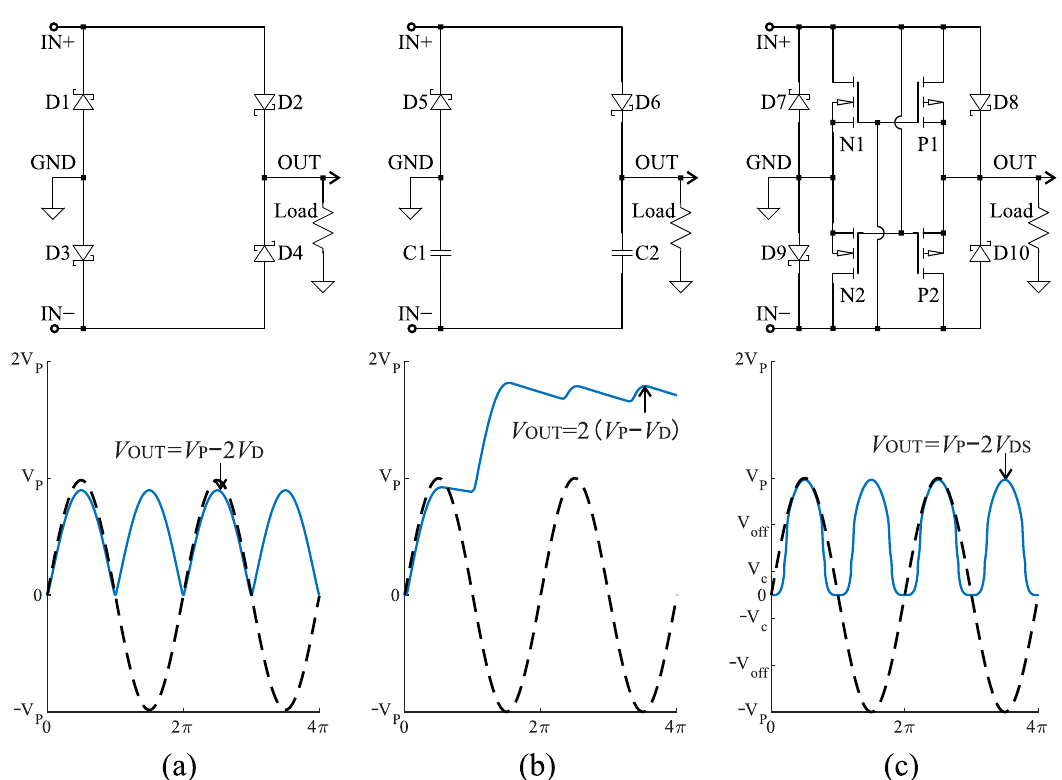
Figure 3. Schematic diagrams of the three rectification circuits, ( a ) full-wave diode bridge rectifier (FWR), ( b ) Delon full-wave voltage doubler (VD), and ( c ) negative voltage converter (NVC), and associated qualitative waveforms of input and output voltage. V P is the amplitude of the input voltage across IN+ and IN −